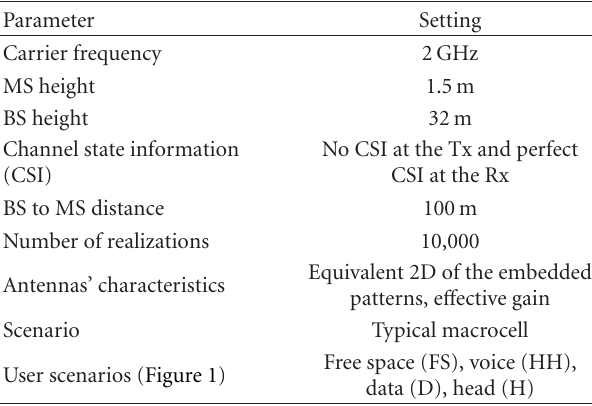
Table 2: Channel models simulation parameters.